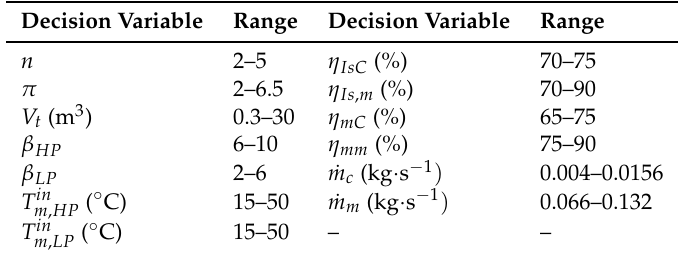
Table 2. Range of each decision